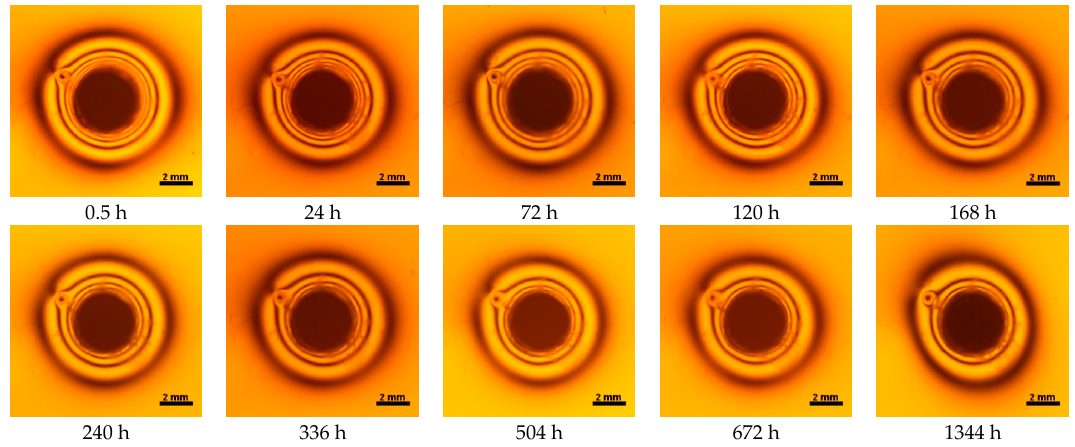
Figure 7. Isochromes in epoxy plate around Ceram.X One restoration before and after water storage 0.5–1344 h.